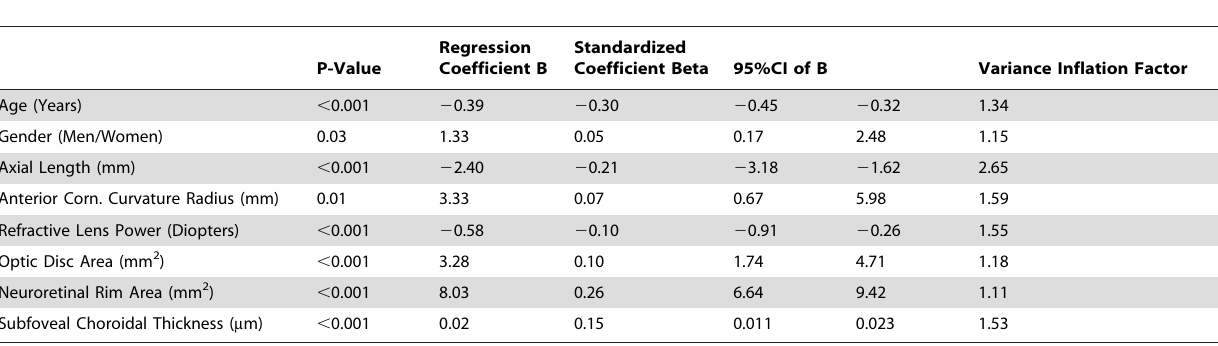
Table 3. Associations between mean global retinal nerve fiber layer thickness as measured by spectral domain optical coherence tomography (iVue SD-OCT) and ocular and systemic parameters in the Beijing Eye Study 2011 (multivariate